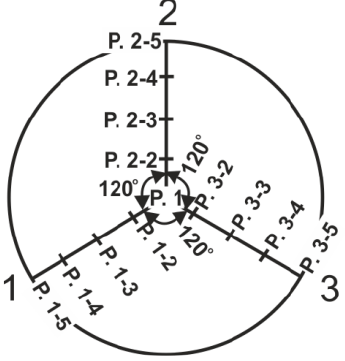
Figure 6. Cross ‐ section of the material after physical modelling of the wire rod rolling process in ‐ cluding marked measuring points: ( a ) general view and ( b ) distance table.